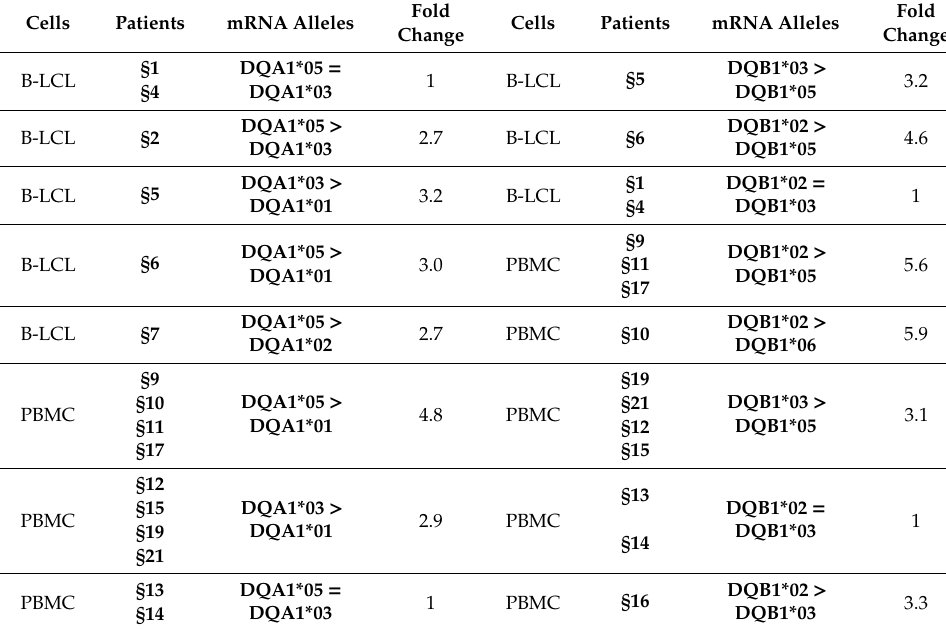
Table 3. DQA1 and DQB1 mRNA fold change in di ff erent